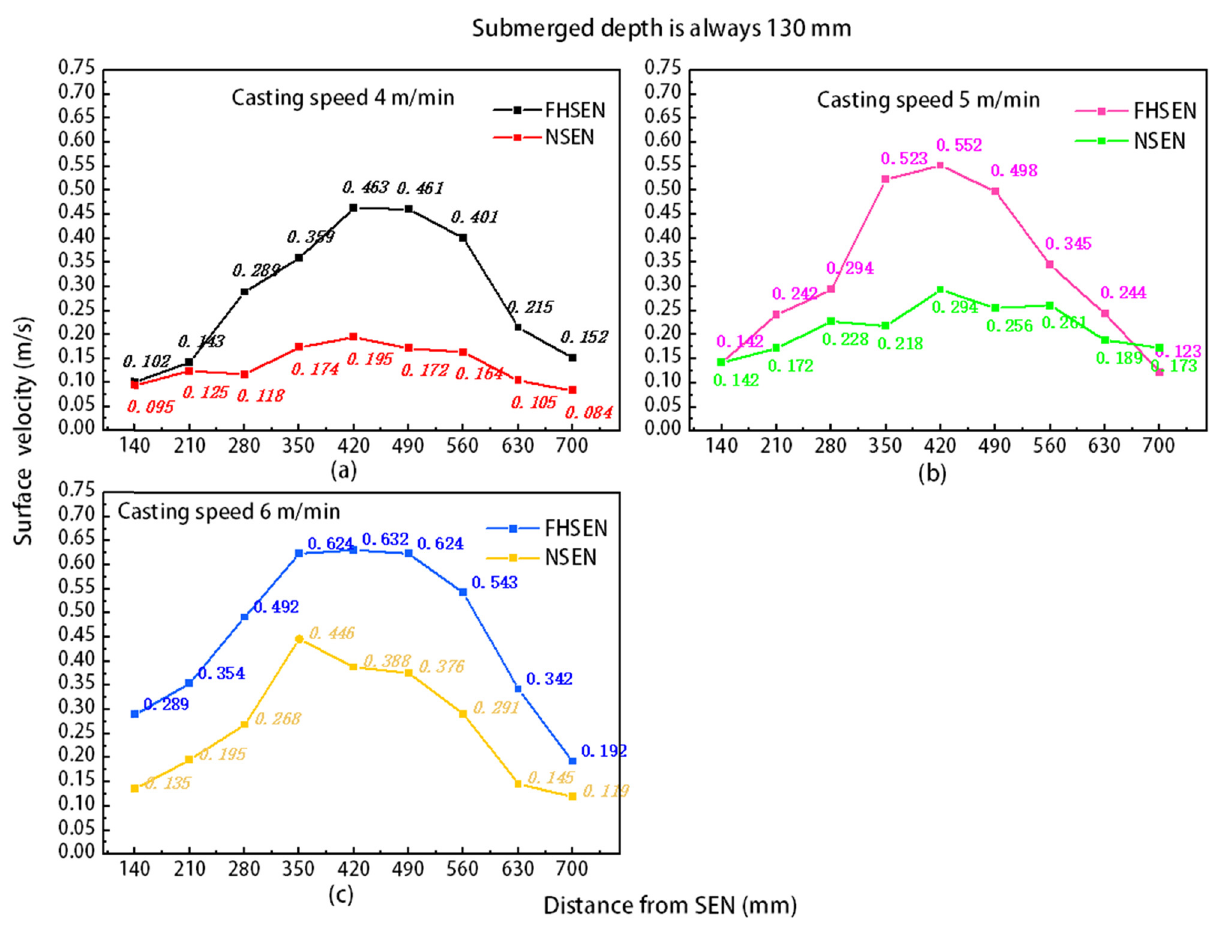
Figure 19: Time - averaged surface velocity by the nail board measurements at a submerged depth of 130 mm: ( a ) 4 m · min − 1 , ( b ) 5 m · min − 1 , and ( c ) 6 m · min − 1